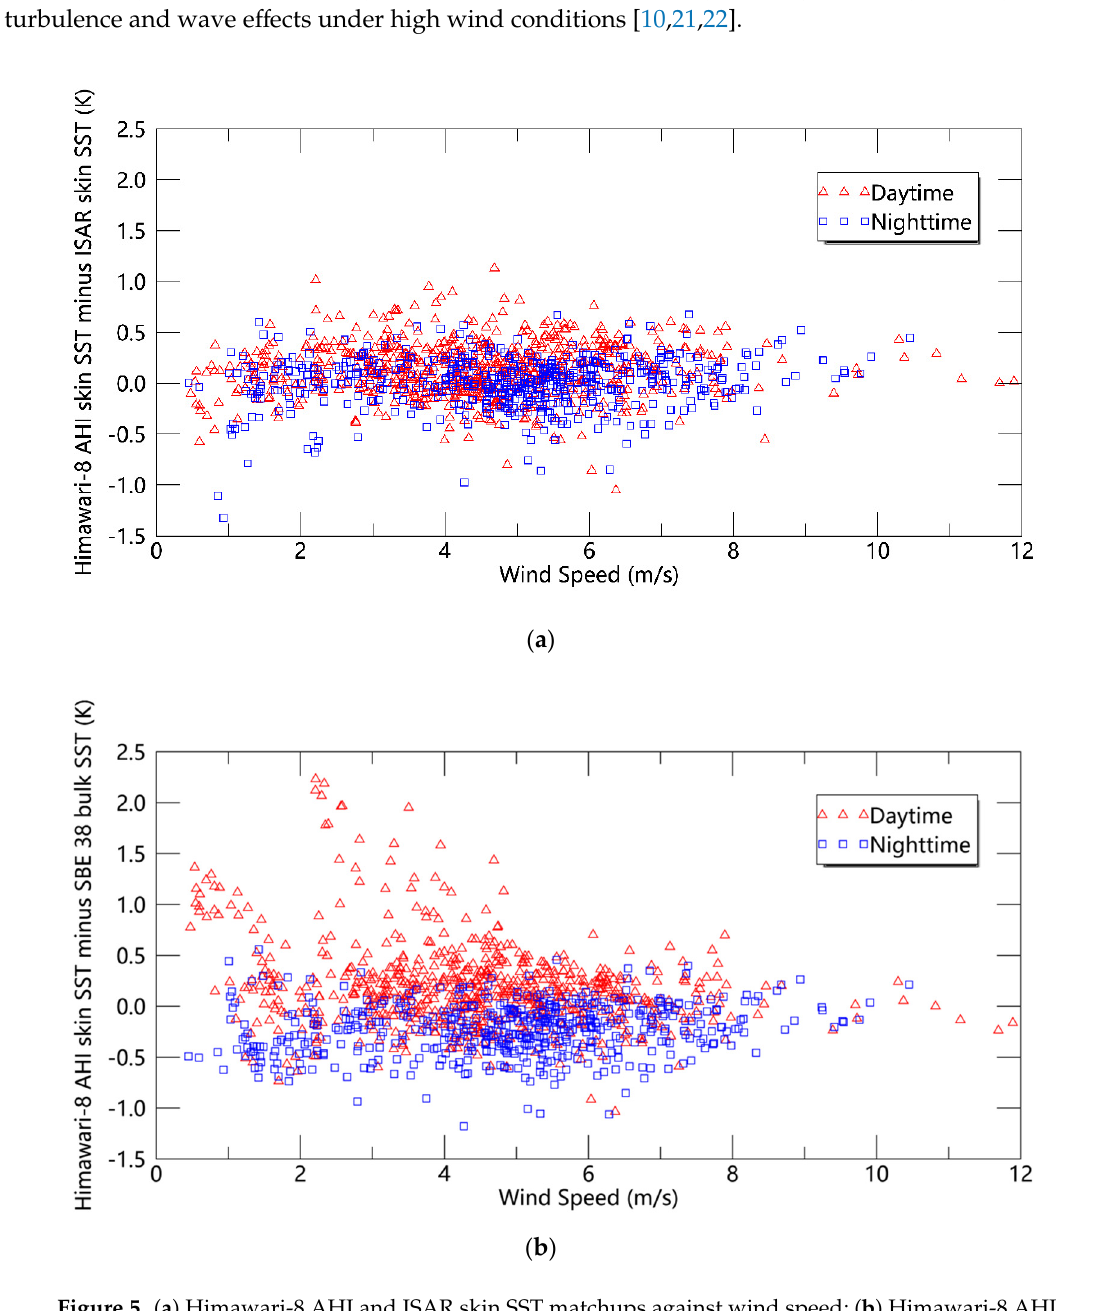
Figure 5. ( a ) Himawari-8 AHI and ISAR skin SST matchups against wind speed; ( b ) Himawari-8 AHI skin and SBE 38 bulk SST matchups against wind speed (red triangle: daytime, blue square: nighttime).